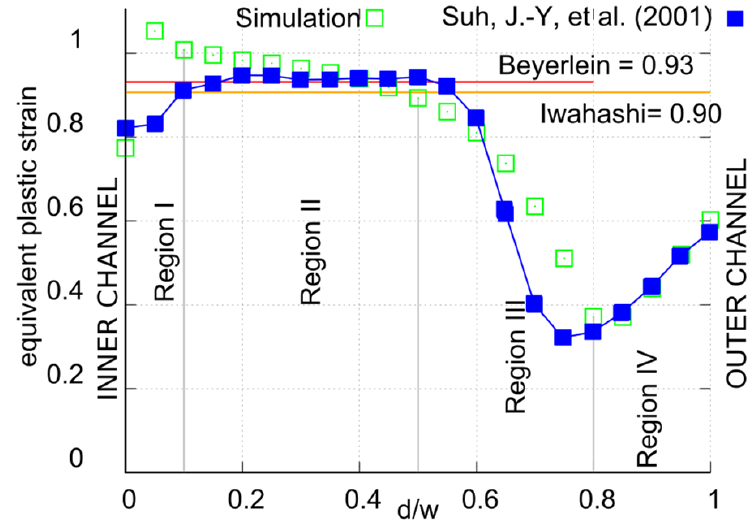
Figure 12. Equivalent plastic strain along ND at the 21 points indicated in Figure 5, adapted from [22]. Quantitatively the degree of inhomogeneity of the plastic strain shown in Figure 12 can be estimated by calculating the strain inhomogeneity index proposed in [13]: